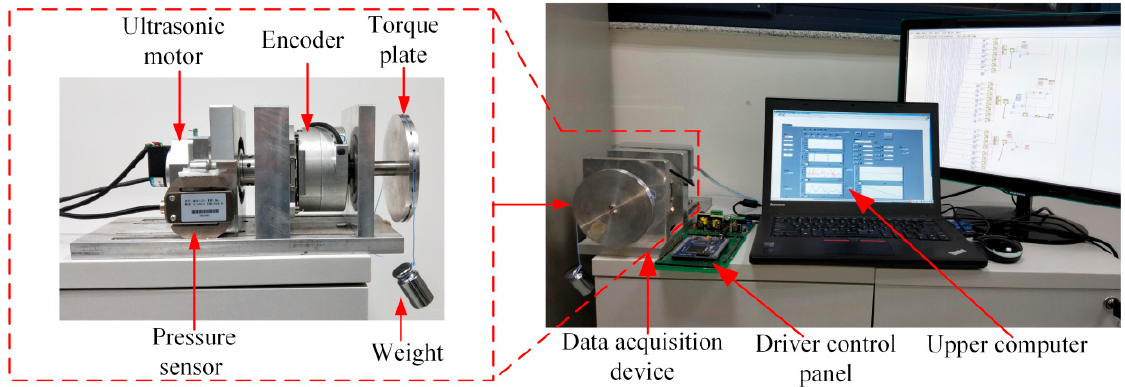
Figure 28. Configuration of the experiment platform.